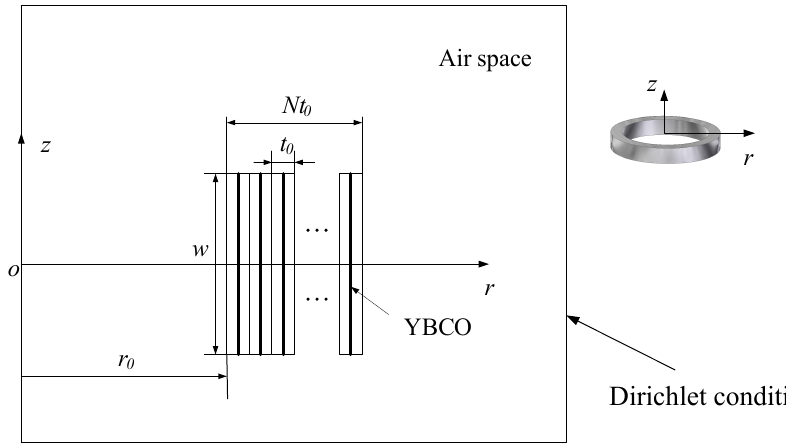
Figure 5. A coil with N tapes: the width is w and the thickness is t 0 . The radius of the coil is r 0 . YBCO superconductor layers are presented by thicker lines.